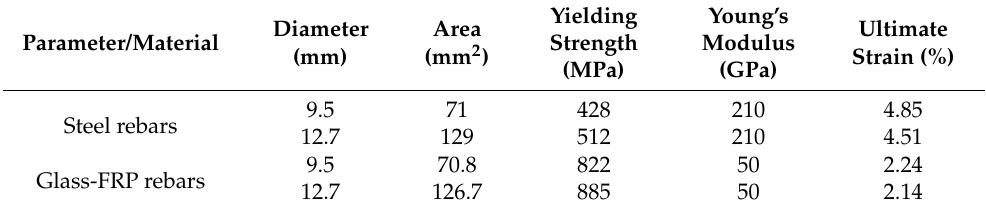
Table 3. Engineering parameters of steel and glass-FRP rebars.